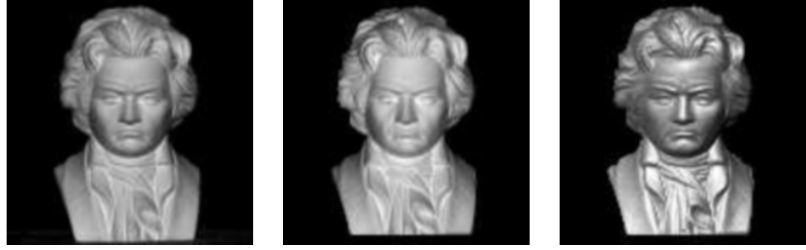
Fig. 5 Depth reconstructions results for both perspective methods. Our methods perform accurate perspective PS able to handle specularities.